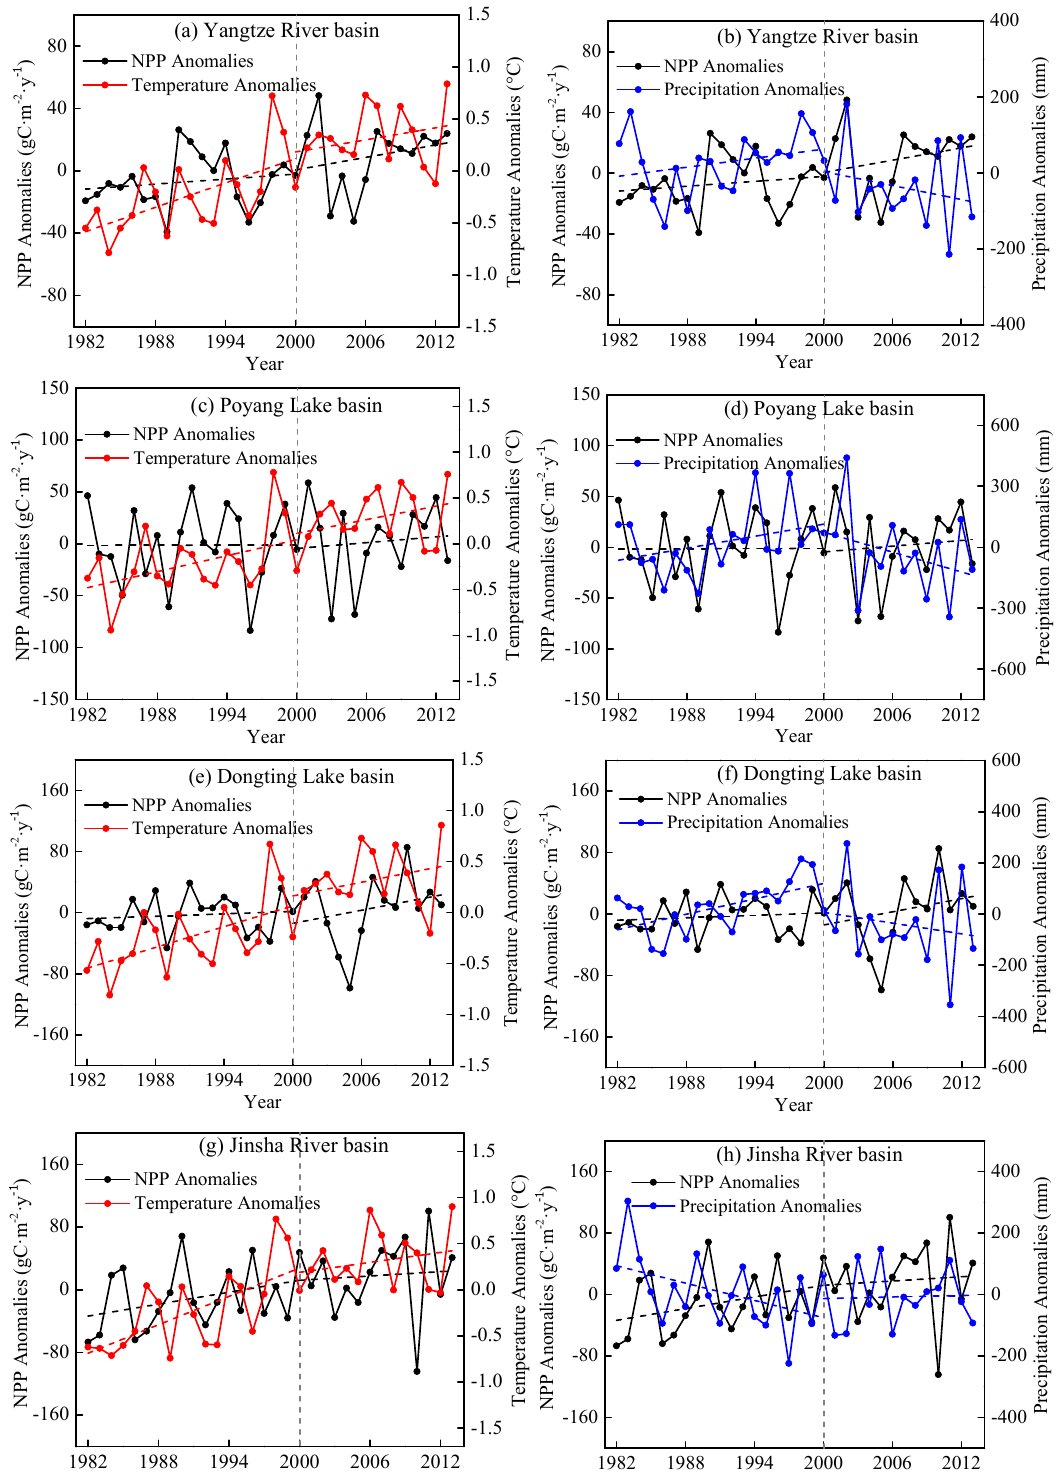
Figure 8. Average annual temperature, precipitation and forest NPP in the Yangtze River basin during the period 1982–2013.